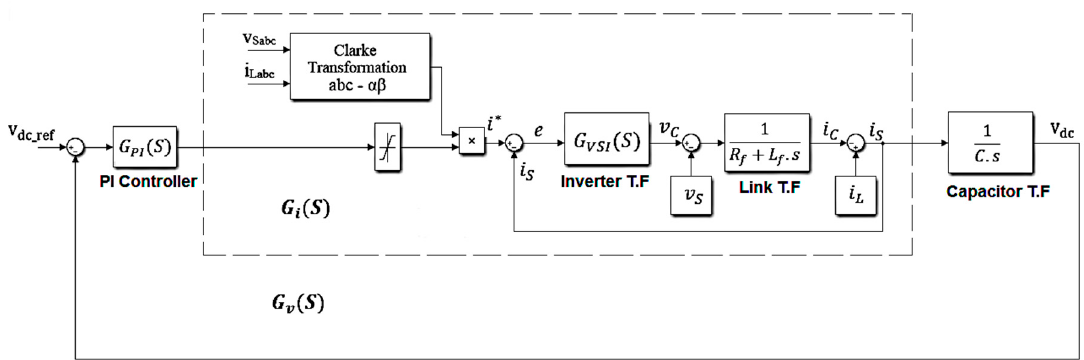
Figure 5. Cascade closed loops of current and voltage.